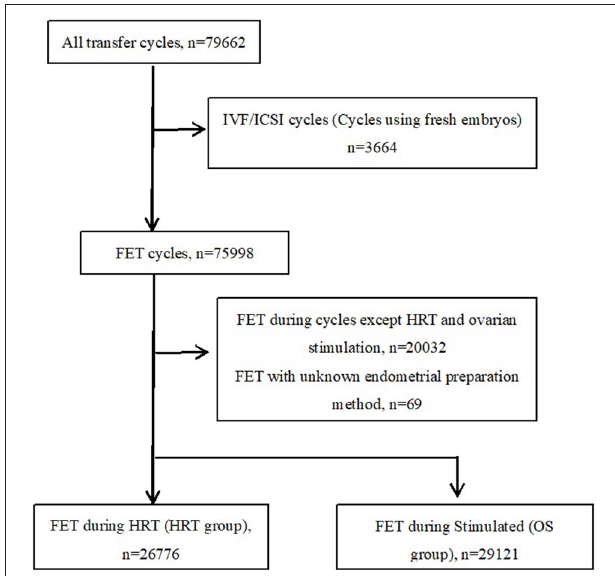
FIGURE 1 | A flow diagram showing the distribution of the study